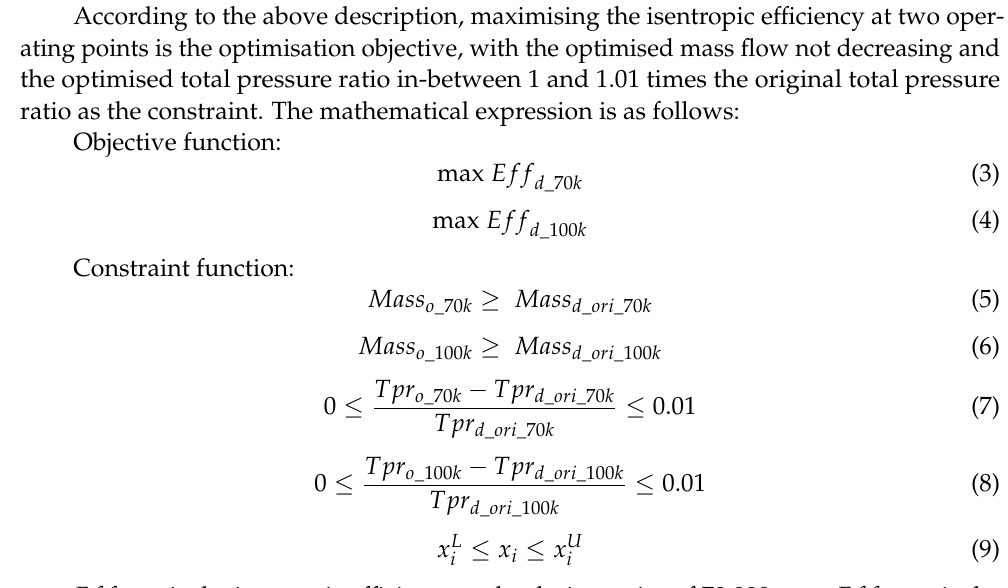
Figure 6. Aerodynamic performance curve at different conditions.